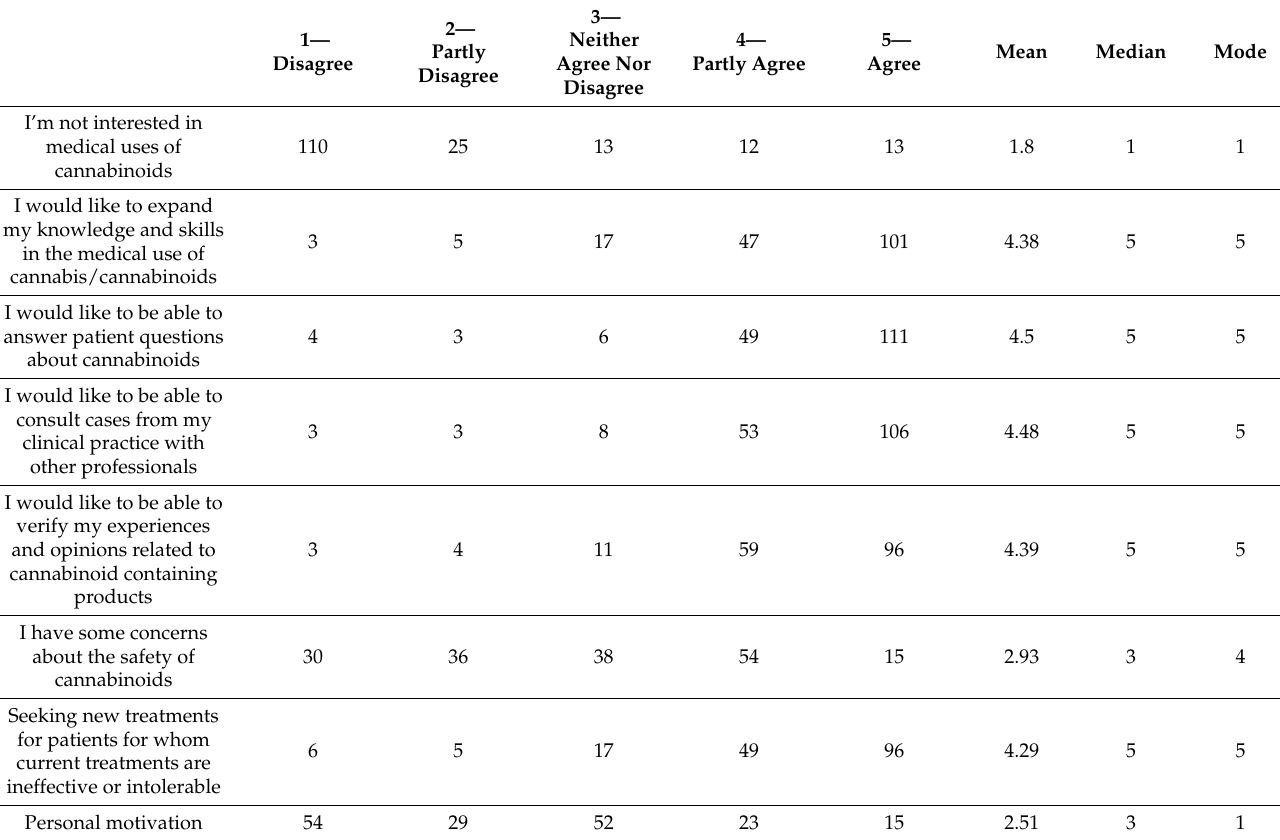
Table 3. Motivation for expanding knowledge on medical uses of